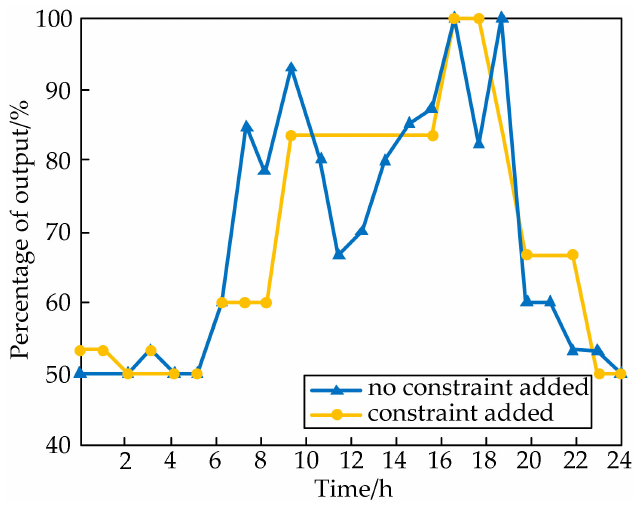
Figure 6. Thermal power unit output curve.